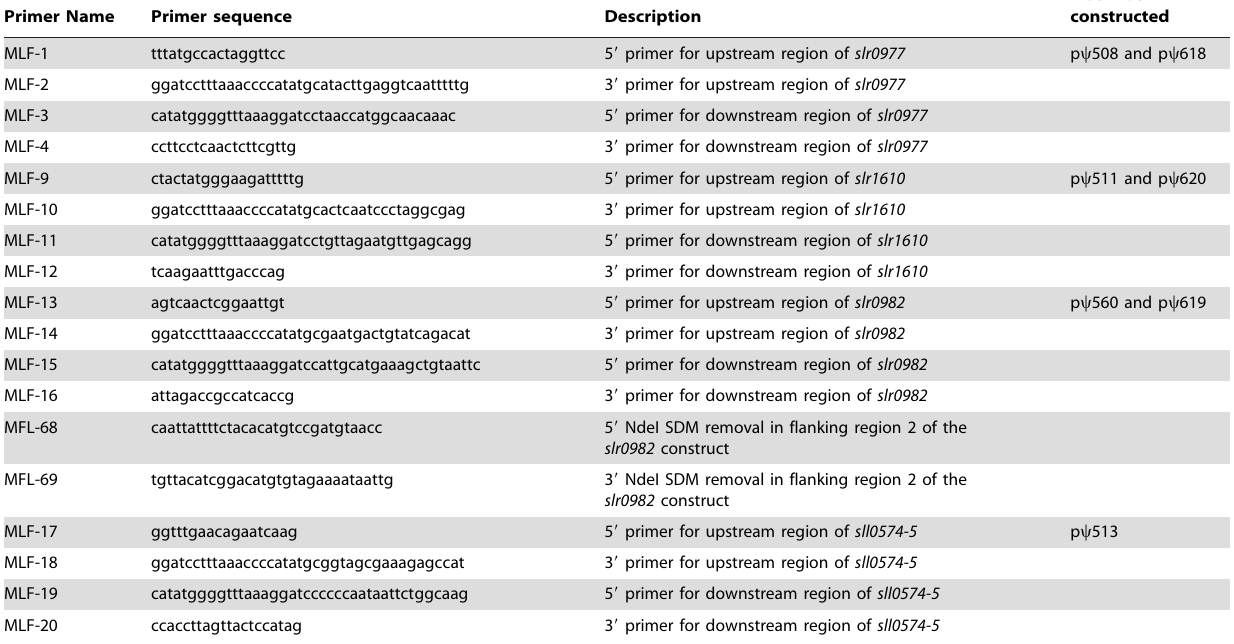
Table 1. Primers used in this